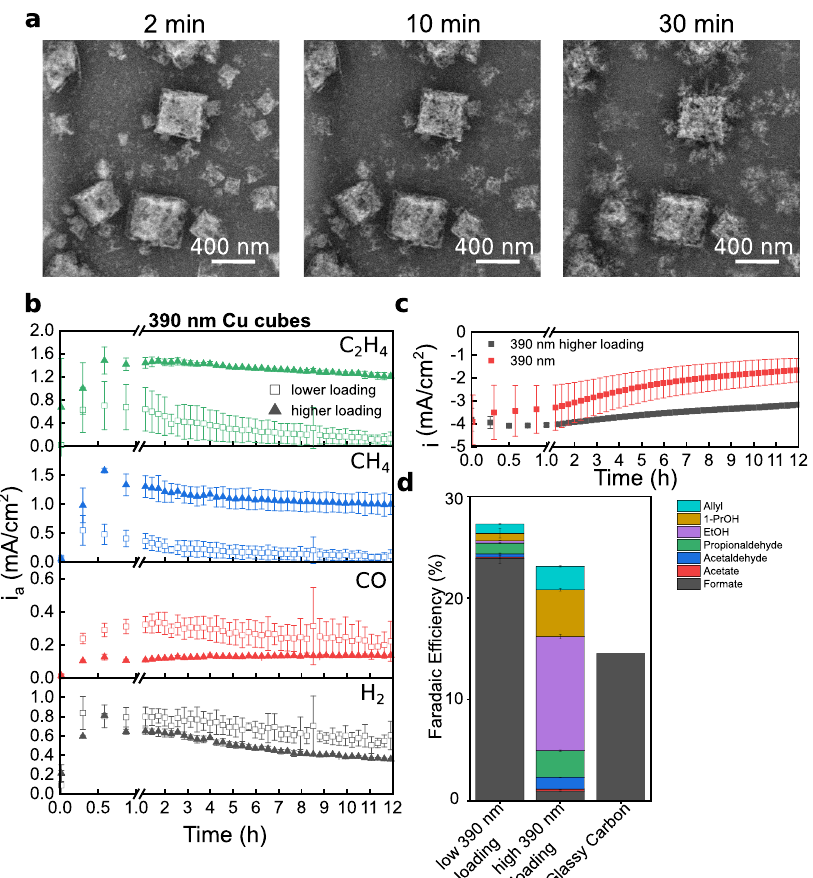
Fig. 5 Comparison of the Cu cube behavior at different loadings. We compare nominally 390 nm Cu cubes at high loading ( a ) at the same potential. In b , we compare the partial current density for the gas products of the high loading sample (390 nm Cu cube size) normalized by the initial loading. We have observed a higher overall current ( c ) and more C 2 + gas and liquid products ( b , d ) at higher loading at − 1.1 V RHE . The error bars give the standard deviation of three